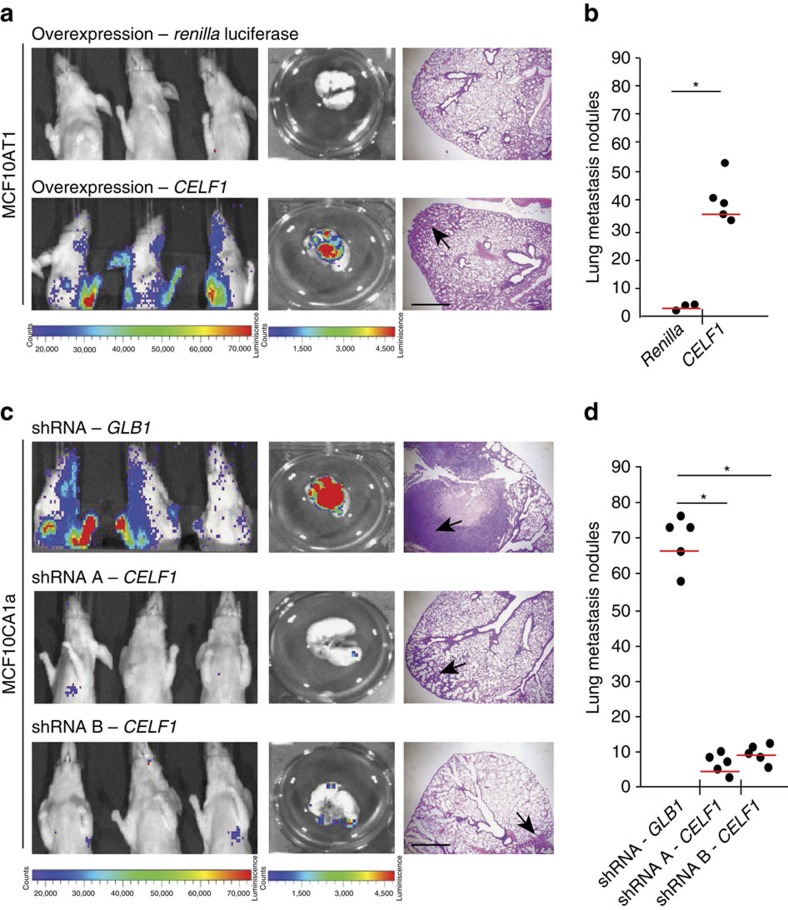
CELF1 drives in vivo metastatic colonization.(a) The effect of CELF1 overexpression on metastatic lung colonization was examined. MCF10AT1 cells stably overexpressing either Renilla Luciferase or CELF1 were injected into the tail vein for experimental metastasis within athymic nude mice. The incidence and progression of metastasis was measured by luciferin injection and bioluminescence imaging of Firefly Luciferase. Mice were killed on day 100 and metastases were quantified in excised lungs by ex vivo bioluminescence imaging. Shown on the right, hematoxylin and eosin staining of the lungs from mice. Scale bar, 1 mm. Black arrows indicate micrometastases. (b) The lungs from each group of experimental animals in a were surgically excised, fixed overnight in 10% buffered formalin and metastatic nodules were counted. Red line denotes 25th percentile. (c) The effect of CELF1 knockdown on metastasis were examined as in a, except that the animals were injected with MFC10CA1a cells stably expressing shRNA hairpins targeting GLB1 or CELF1 (2 distinct shRNAs). Scale bar, 1 mm. (d) The lungs from each group of experimental animals were surgically excised, fixed overnight in 10% buffered formalin and metastatic nodules were counted. Red line denotes 25th percentile. In b and d, *P≤0.05 (Student's t-test). See also Supplementary Fig. 5.